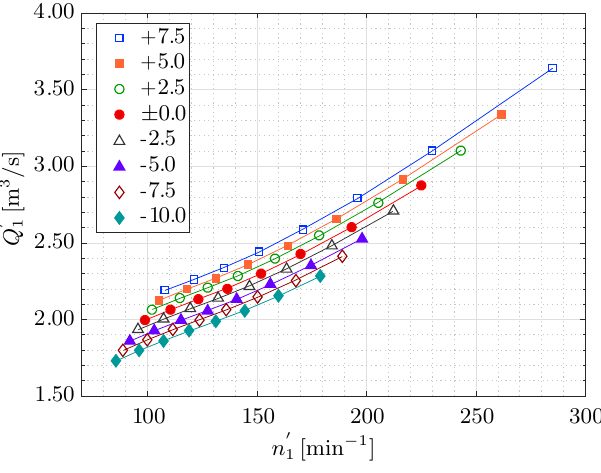
Fig. 8. Unit discharge at guide vane angles γ from +7.5 ◦ to -10 ◦